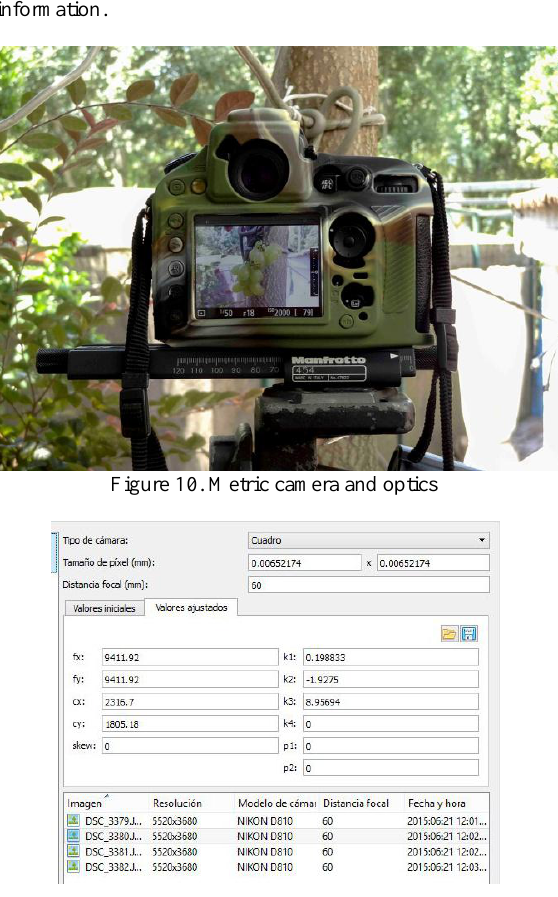
Table 1. Calibration parameters of the Nikon 810D